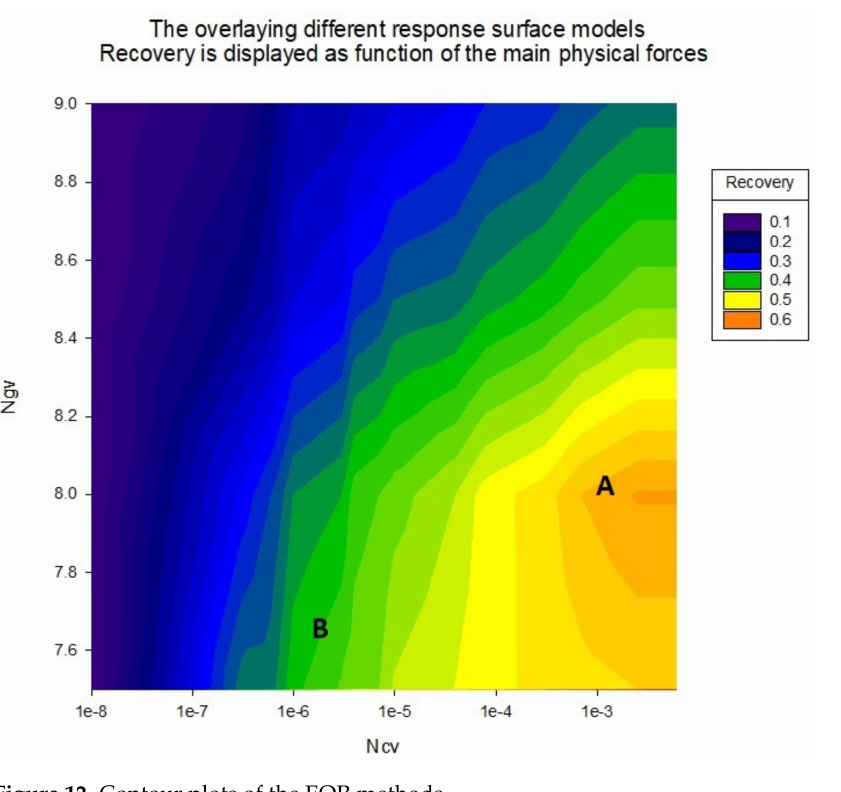
Figure 12. Contour plots of the EOR methods.